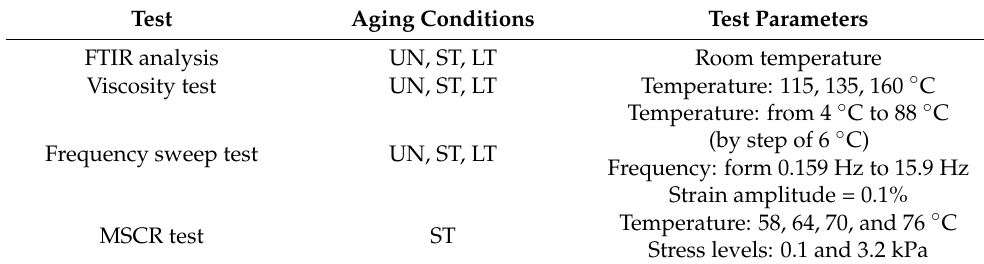
Table 4. Experimental program of each blend.